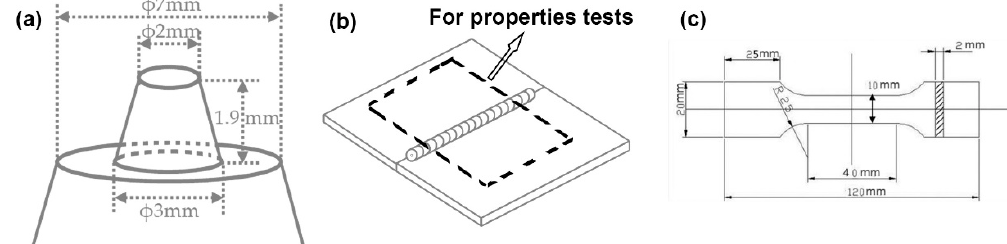
Figure 1. Schematic illustration of ( a ) dimensions of the FSW (Friction Stir Welding) tool and ( b ) samples extraction from the plate for properties tests, and ( c ) corresponding dimensions.